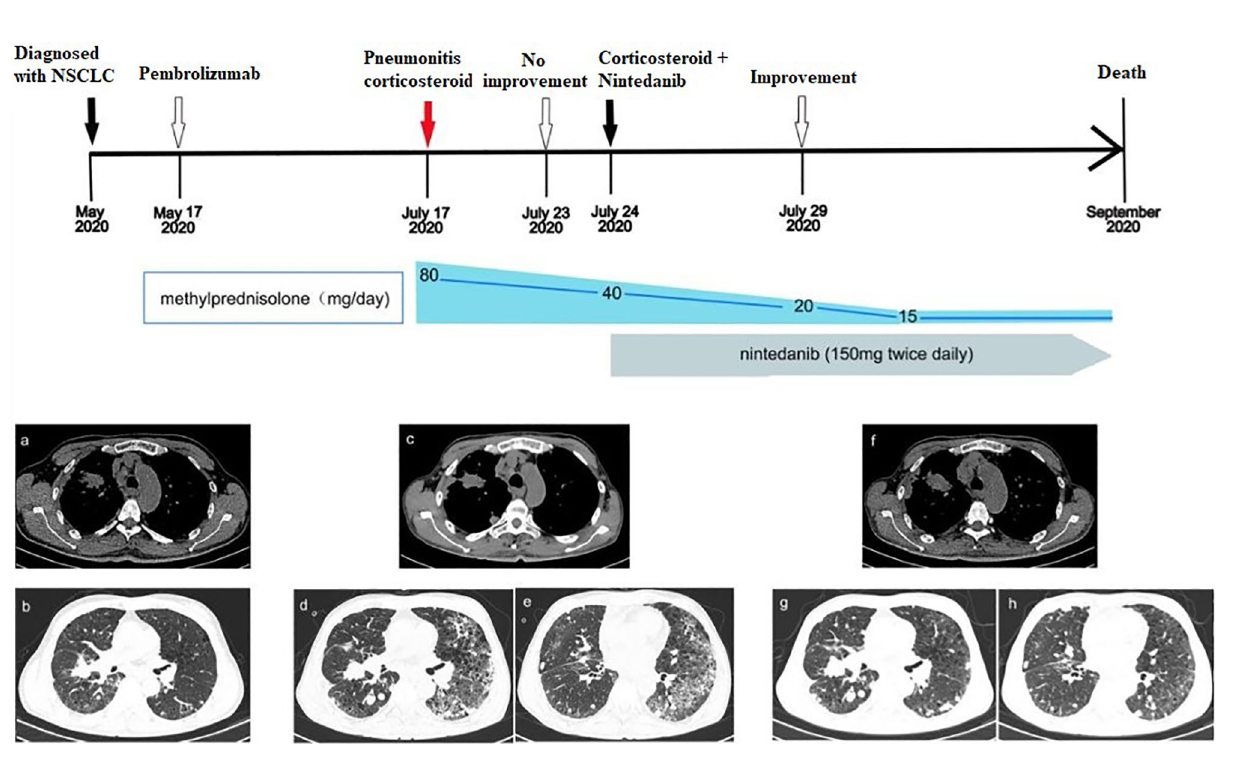
FIGURE 1 | Development of ICI-related pneumonitis in a patient treated with pembrolizumab for lung adenocarcinoma. (A, B) Chest CT images showed the lesions in the upper lobe of the right lung before treatment (May 17, 2020). (C – E) After 3 cycles of immunotherapy, CT images showed that primary lesions were stabilized, but pneumonitis in the left lung (July 24, 2020). (F – H) CT images showed obvious improvement of pneumonitis (July 29,